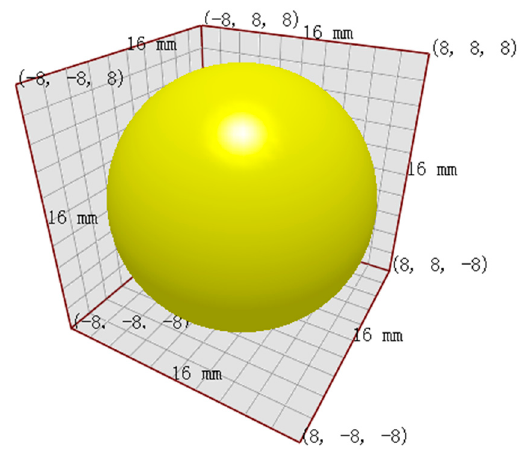
Figure 4. Soil particle model.